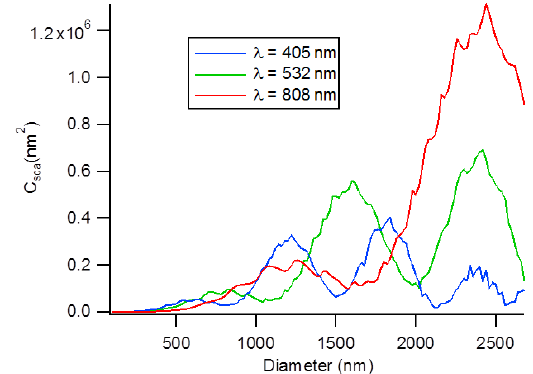
Figure 5. Values of C sca vs. particle diameter calculated from the scattnlay algorithm for wavelengths used in commercially available lasers. Refractive index: 1.59; collection angle: 10–12 ◦